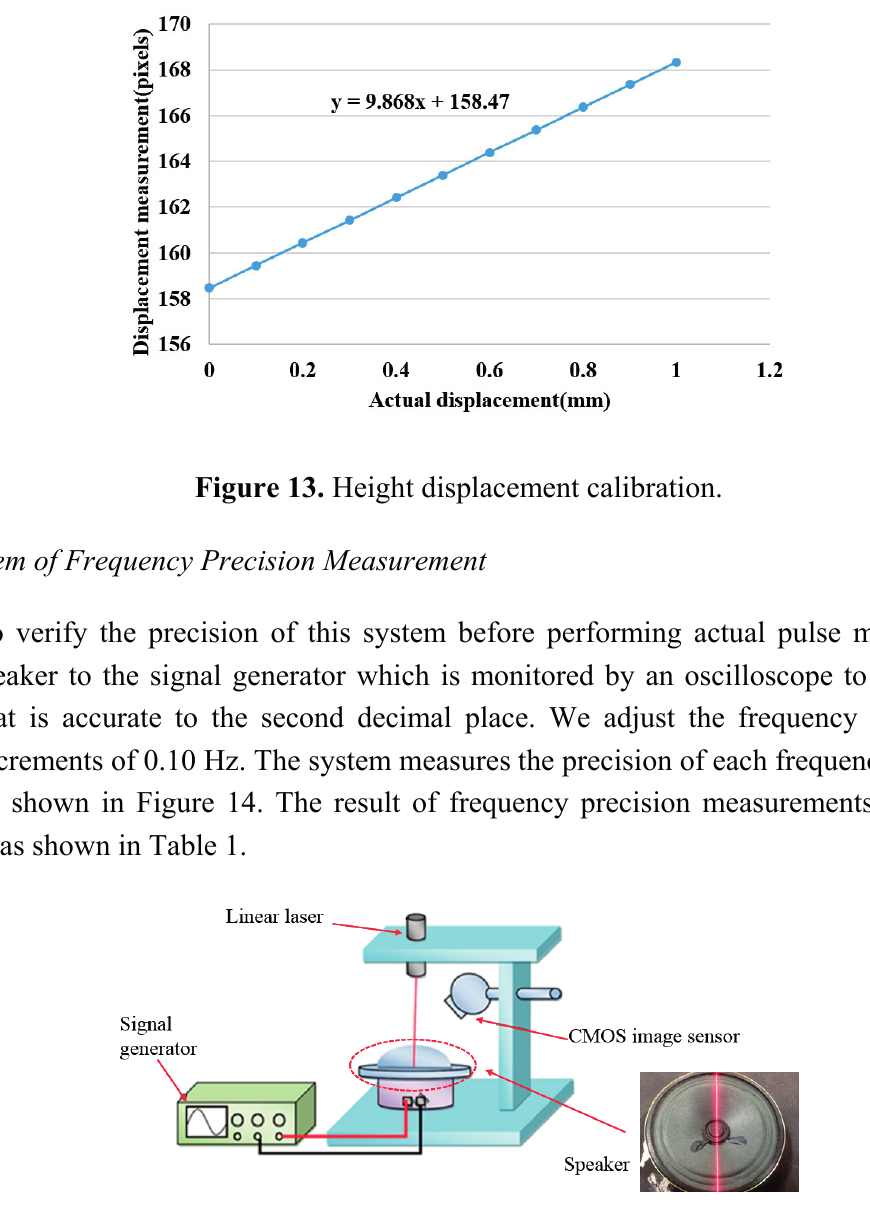
Figure 14. The experimental architecture of the frequency precision